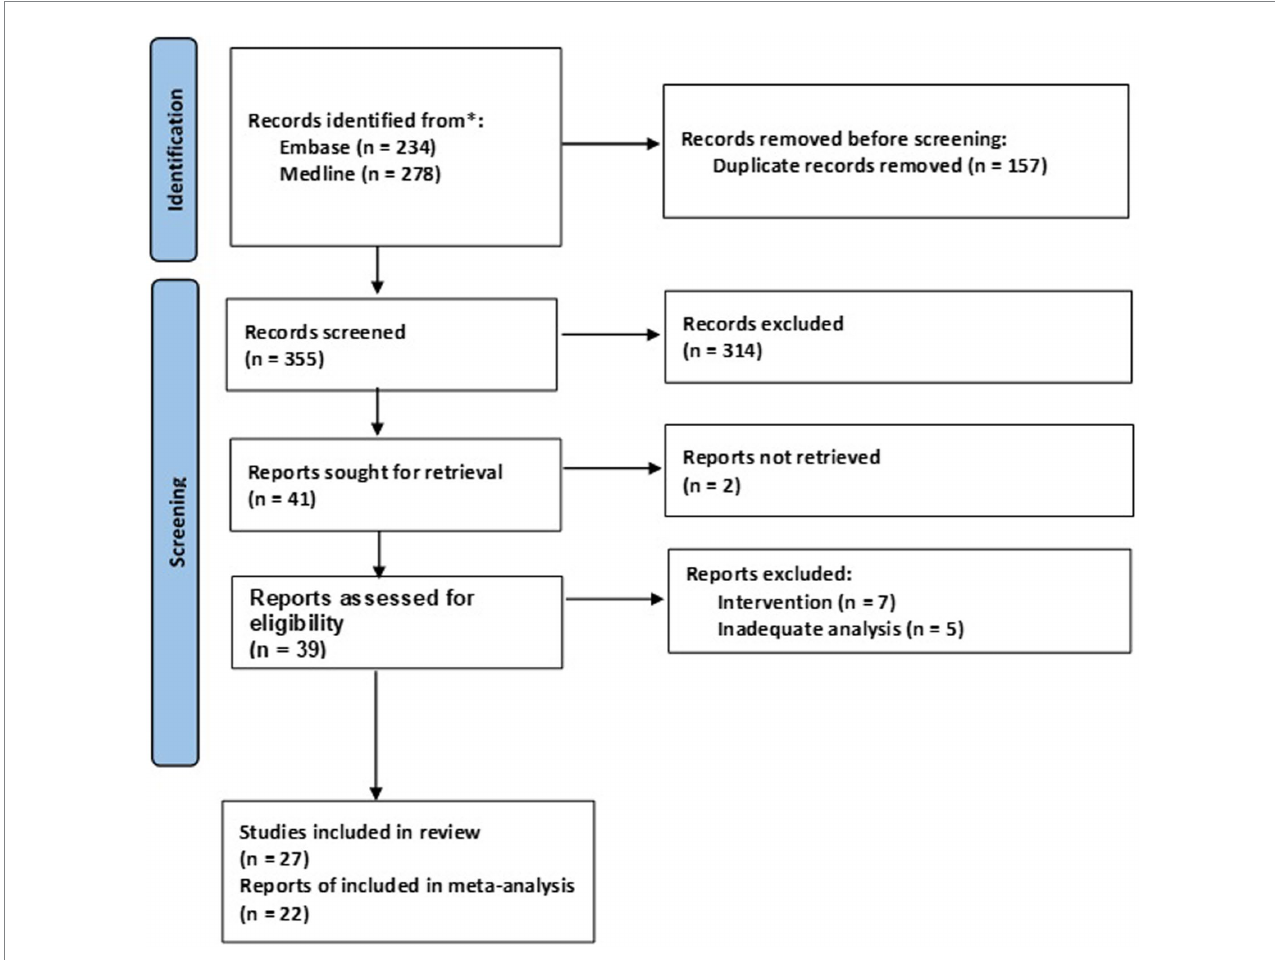
FIGURE 1 PRISMA flow chart for the included